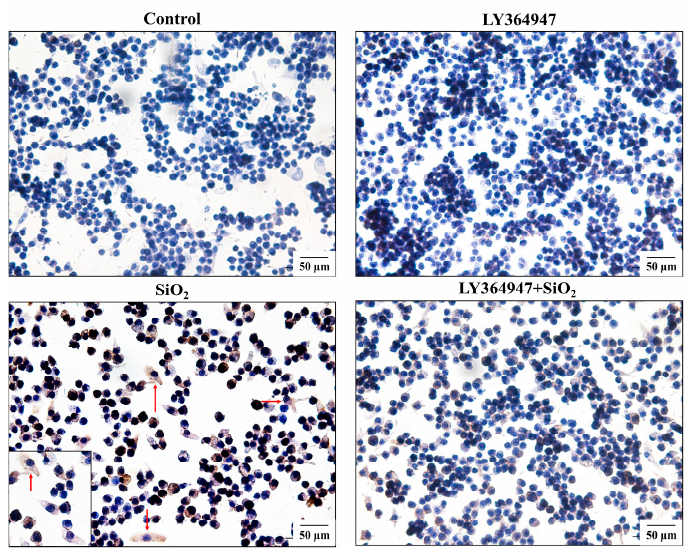
Figure 11. The expression of α -SMA was observed by immunocytochemical staining (scale bar = 50 µm).